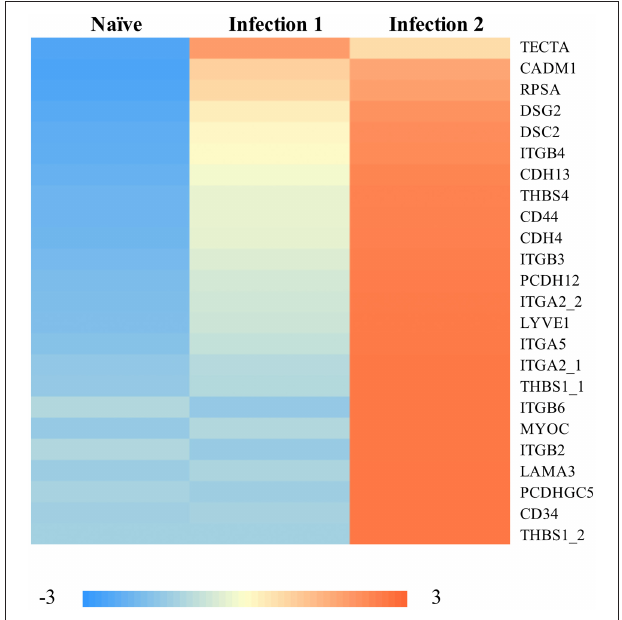
FIGURE 3 | Heatmap of the standardized FPKM gene expression, showing relative levels of abundance of differentially regulated transcripts with functional properties in “cell-adhesion” between naïve and animals during the 2nd infection. Numbers following an underscore represent putative duplicated genes.